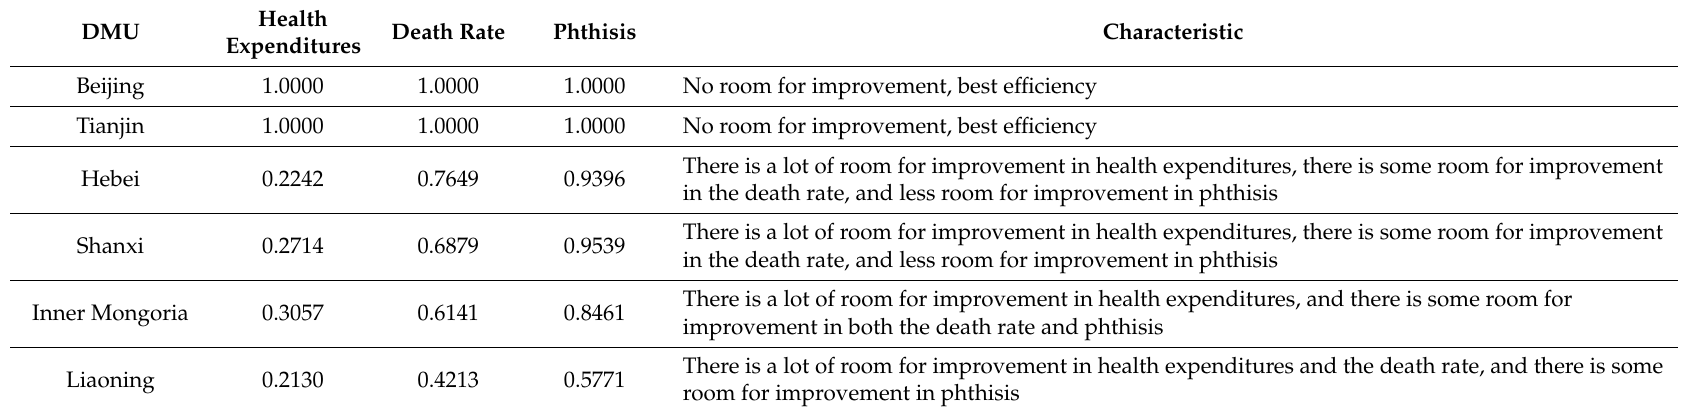
Table 10. E ffi ciency characteristics of health treatment stage